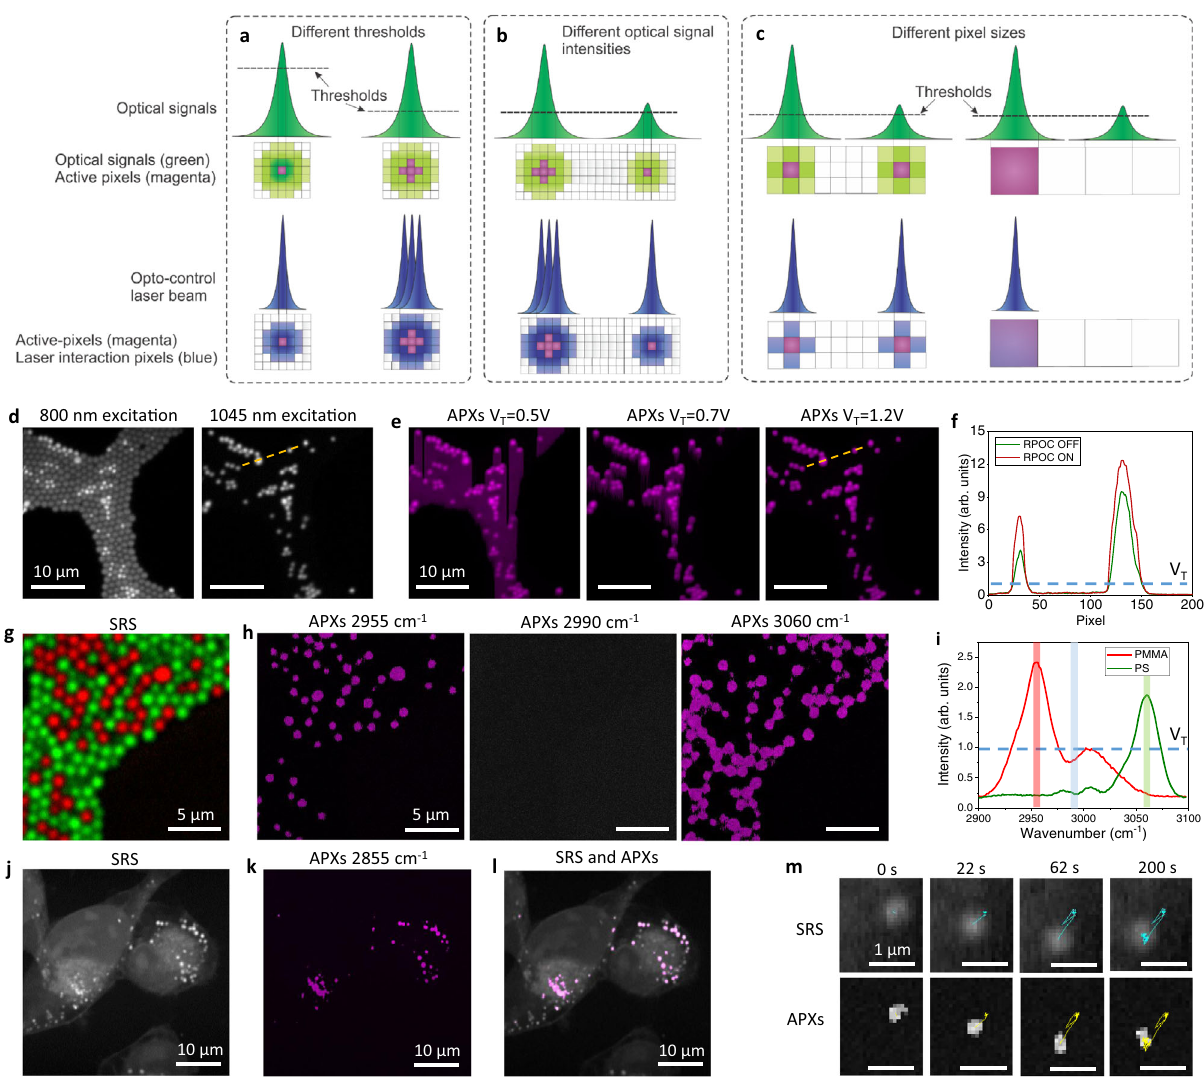
Fig.2|MappingoutRPOCactivepixels(APXs).a AnillustrationofAPXselection using different signal thresholds in the over-sampling condition. The green pulses and pixels indicate optical signals, the magenta pixels indicate APXs, and the blue pulsesandpixelsindicatetheinteractionpulsesandpixels. b AnillustrationofAPX selection using different optical intensities in the over-sampling condition. c An illustration of APX selection at larger pixel sizes for different optical signals. d Mixed fl uorescent particles detected in the 570/60nm channel excited by 800nmpulses(left)and1045nmpulses(right). e APXsdeterminedusingdifferent voltage threshold V T values for the signals from the 570/60nm channel. f Comparing the 570/60nm channel optical intensity when the RPOC is turned on